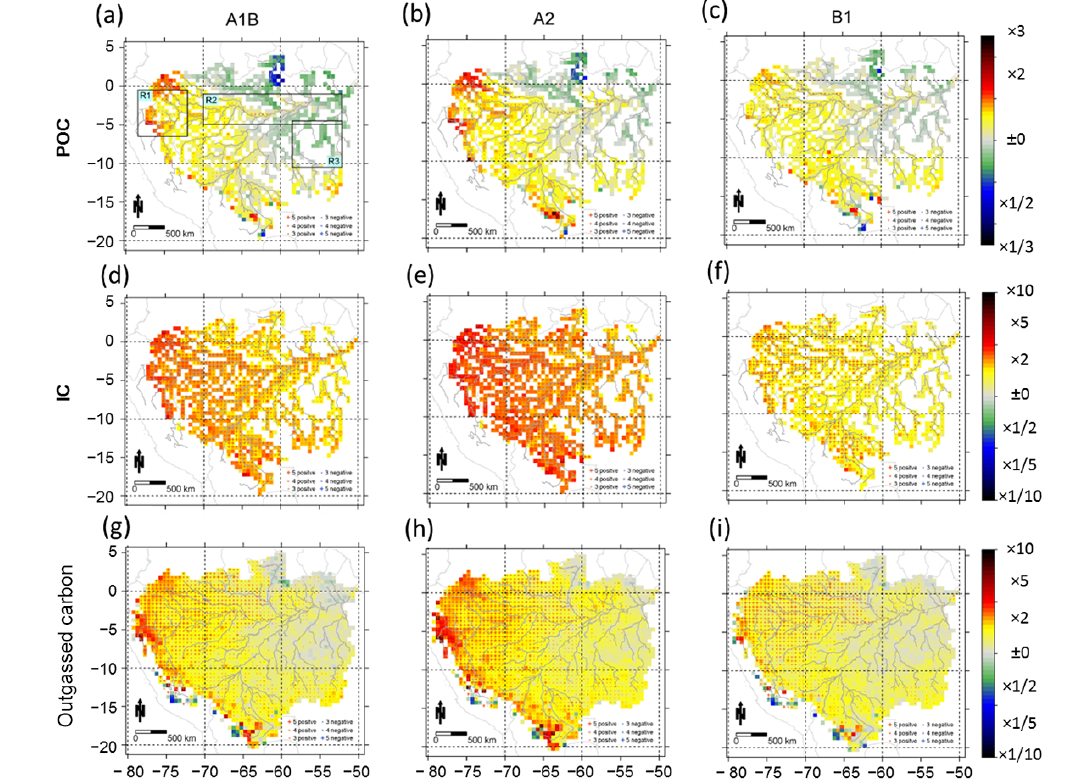
Figure 6. Change in riverine and outgassed carbon caused by climate change. Model mean of the relative increase and decrease in future mean and reference mean of POC (a–c) and IC (d–f) and outgassed carbon (g–i) . Left-hand side panels (a, d, g) show the mean of the quotient for SRES A1B emission scenario, middle panels (b, e, h) that for A2 and right-hand side panels (c, f, i) that for B1, averaged over five climate models and scenarios. Positive values (yellow and red) indicate an increase and negative values (green and blue) indicate a decrease. Additionally to the mean, the number of climate models and scenarios leading to significant trends ( p <0.05, Wilcoxon rank-sum test) is indicated by crosses. In white cells the differences between future and reference values are not